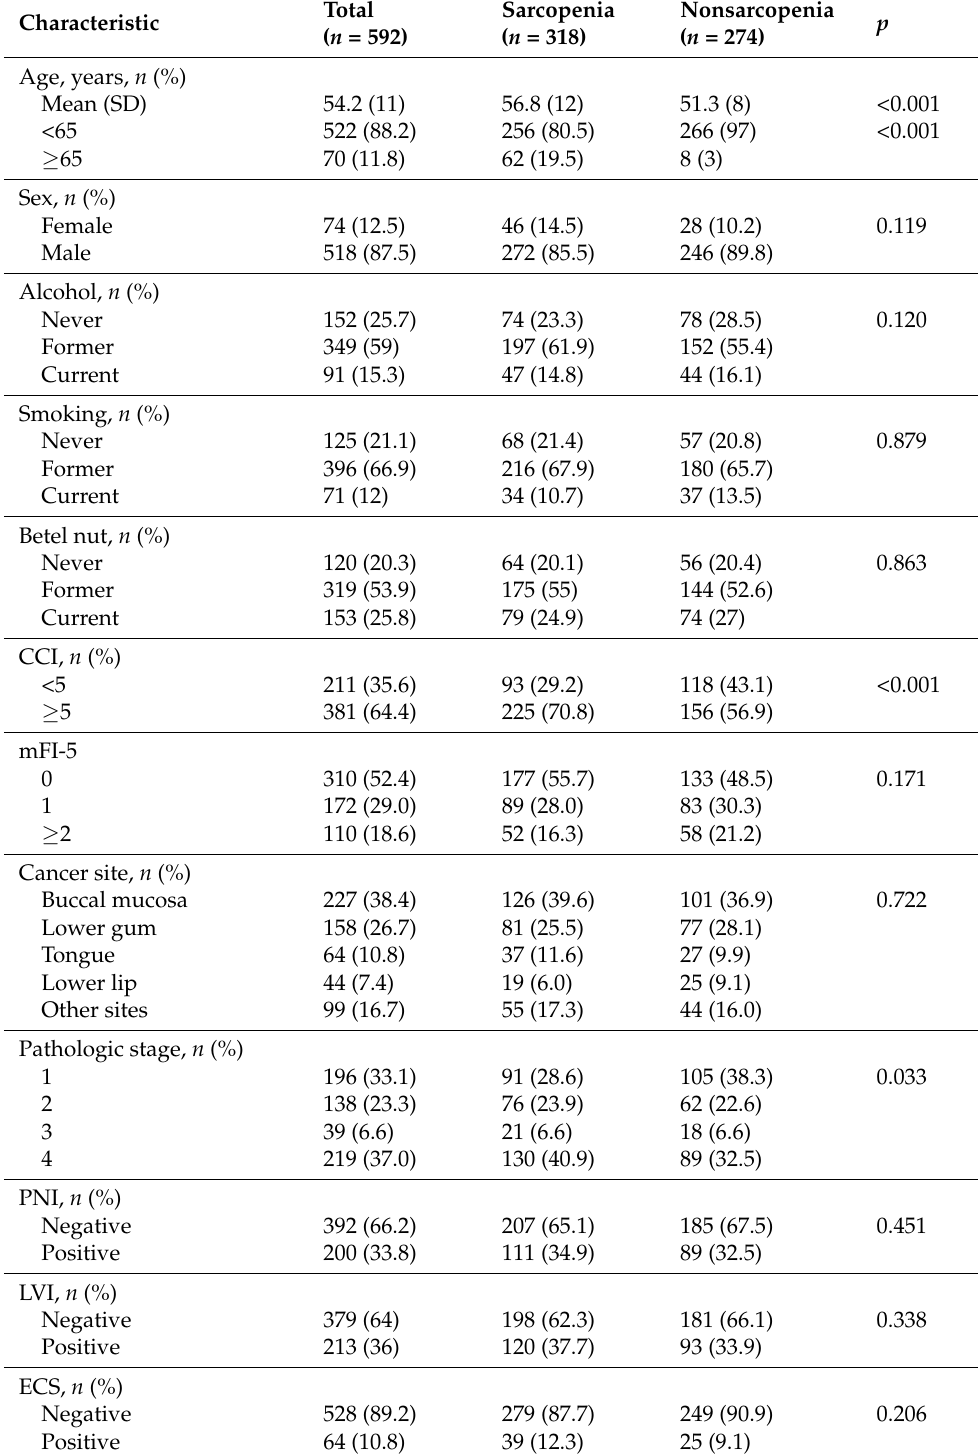
Table 1. Patient characteristics classified by sarcopenia before